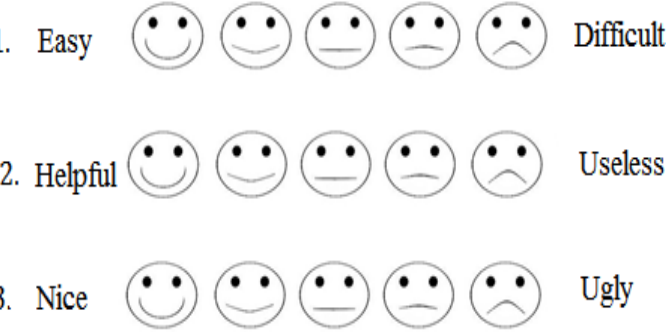
Figure 3. Examples of the modified (“smiley face”) Likert scales used with children under six years.